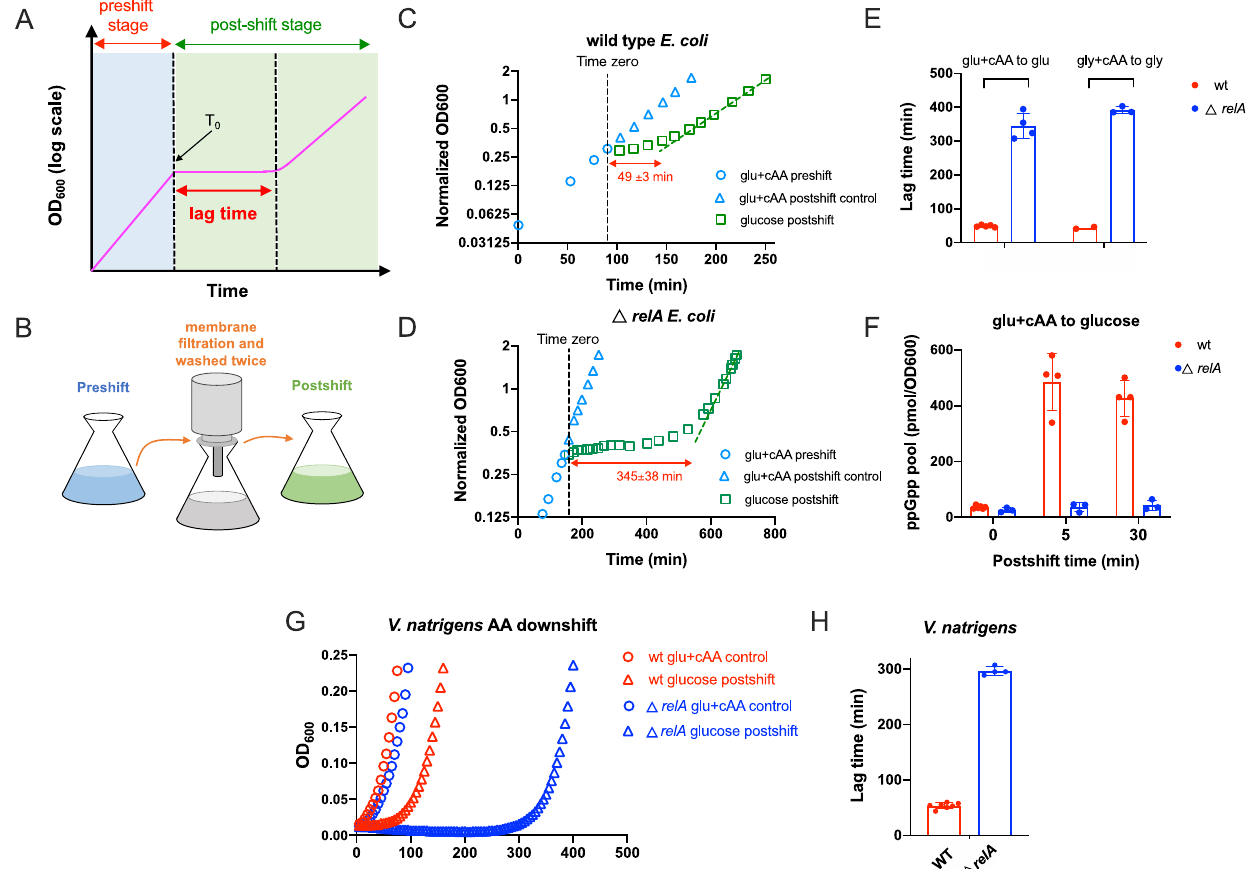
Fig.1|Growthcurveandlagtimeof E.coli and V.natriegens duringaminoacid downshift (AA downshift). A Illustration of a typical bacterial growth curve of